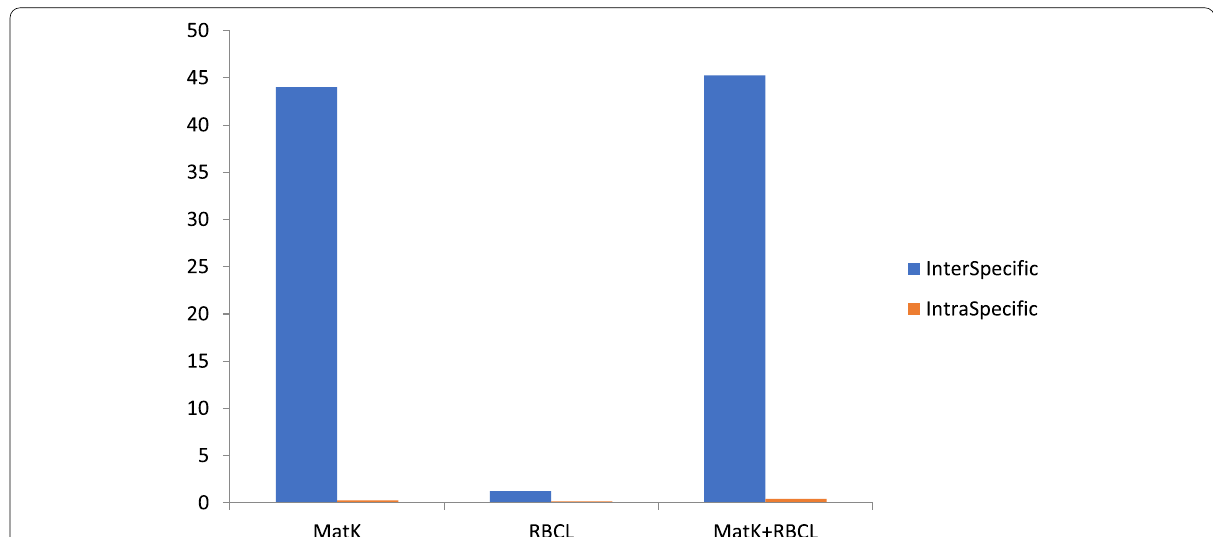
Fig. 7 Interspecific and intraspecific relationships between matK and rbcL gene of twelve accessions of S. tenuifolium and S. vaginatum collected from different locations